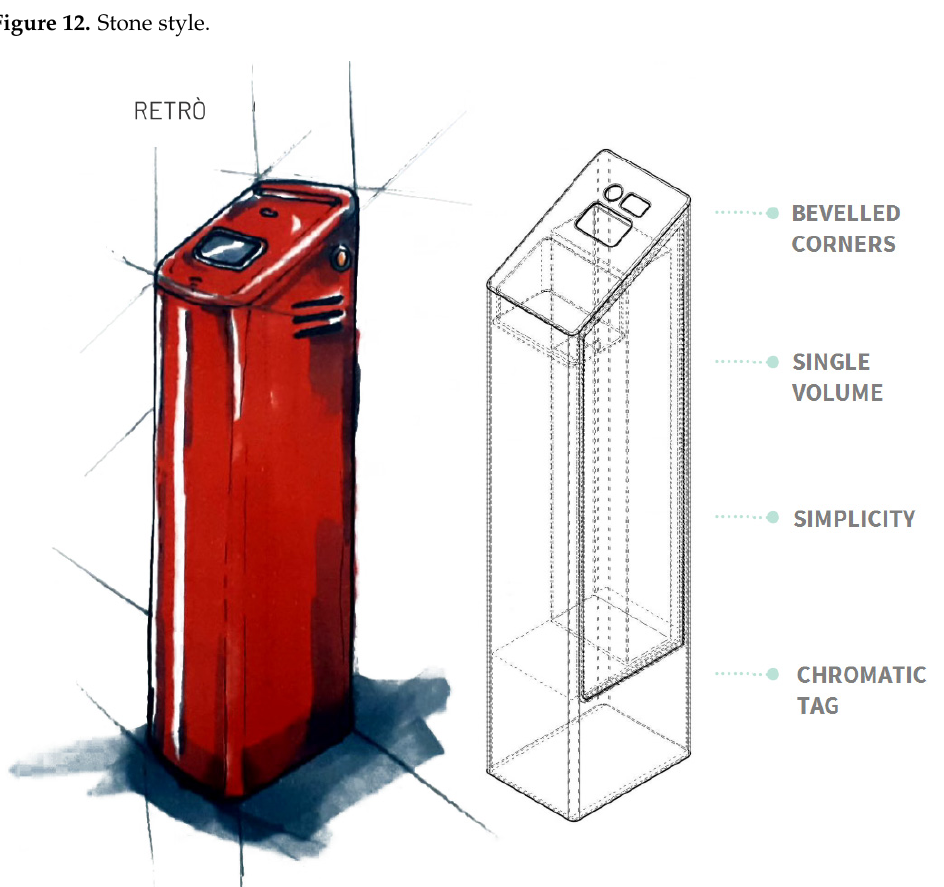
Figure 13. Final Choice—retro style.